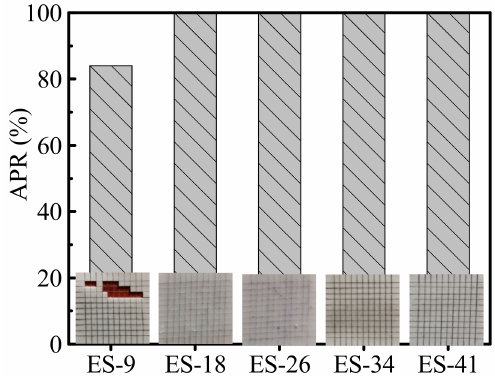
Figure 7. Anti-peeling rate of epoxy-modified silicone tie-coating on epoxy